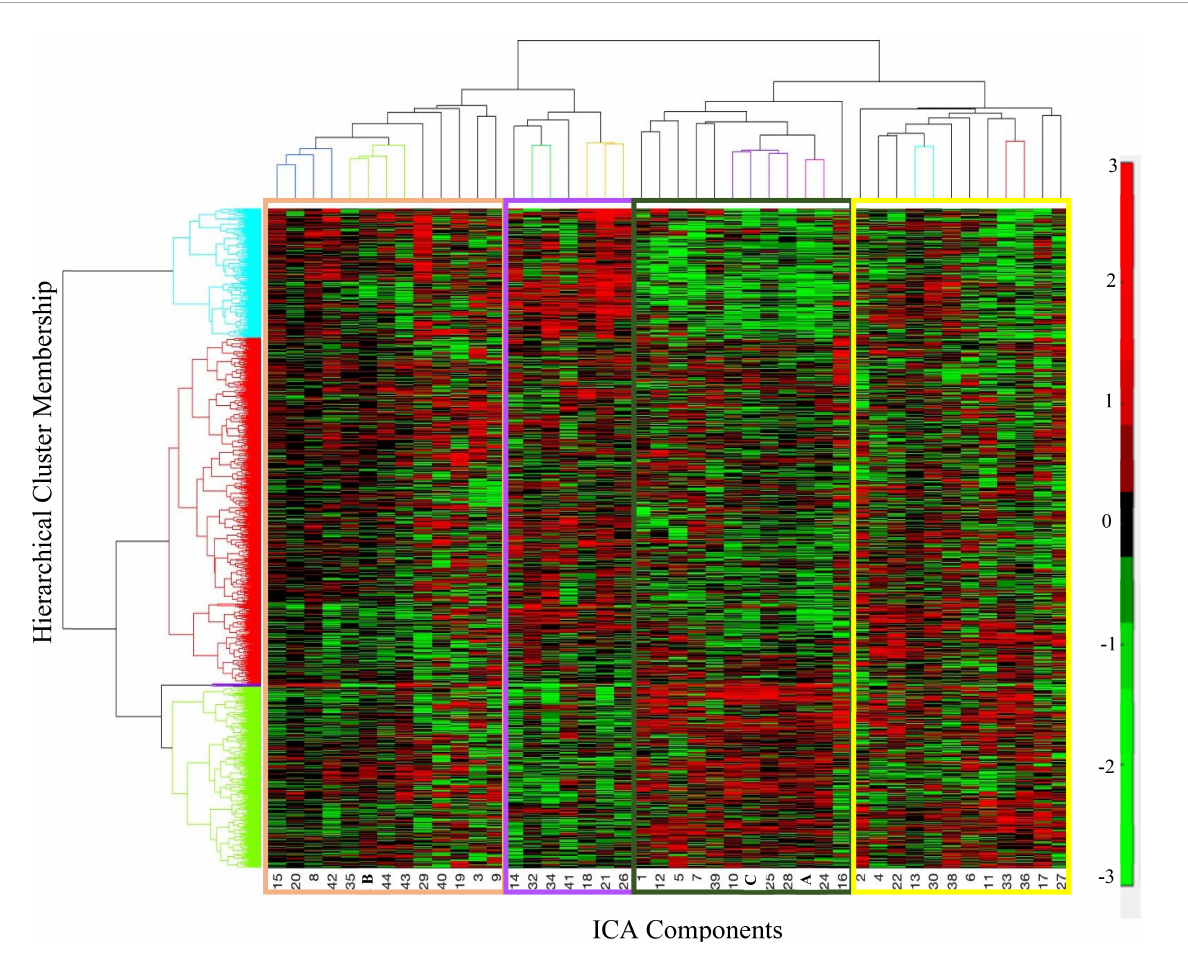
FIGURE5 Hierarchical cluster analysis of independent component analysis (ICA) loading coefficients resulted in four clusters of participants (Y-axis, rows). The y-axis shows the cluster membership, the X-axis shows the ordering of the ICA components. The organization of the components along the X-axis is color-coordinated with Table 5 . The tan cluster is largely comprised of posterior cortical regions. The purple cluster is largely negatively weighted on the cerebellar regions. The dark green cluster includes Components A and C as well as cerebellar and subcortical components. The yellow cluster includes most of the frontal as well as cortical components from every other lobe. See Table 5 for more details on the peak locations of each component. In the color bar, red represents positive loading coefficients and green represents negative loading coefficients.